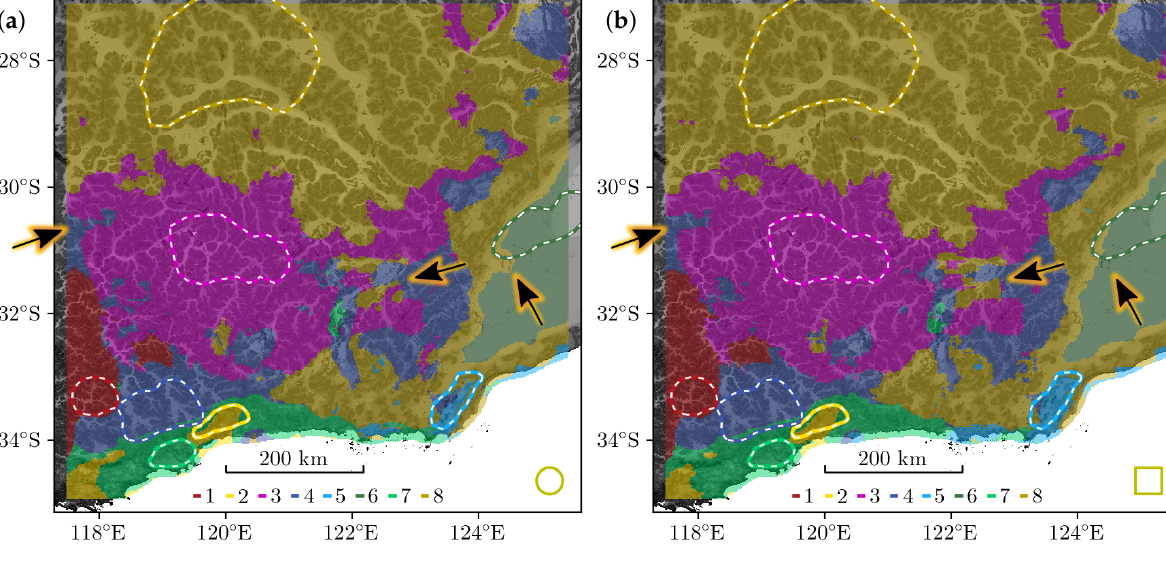
Figure 7. Circular tiles ( a ) tend to result in less blocky shapes, and slightly improve detail over rectangular tiles ( b ). Markers indicate some of the generally subtle differences. RF-100 at s =